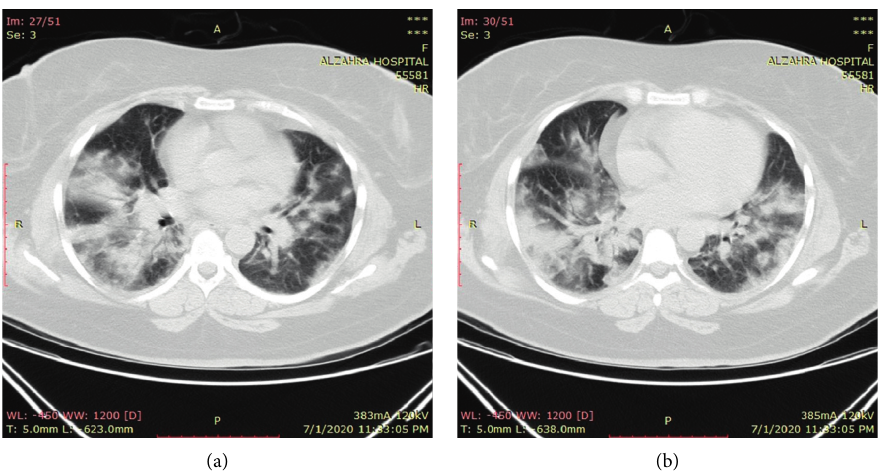
Figure 4: Multifocal multilobular consolidation and ground-glass